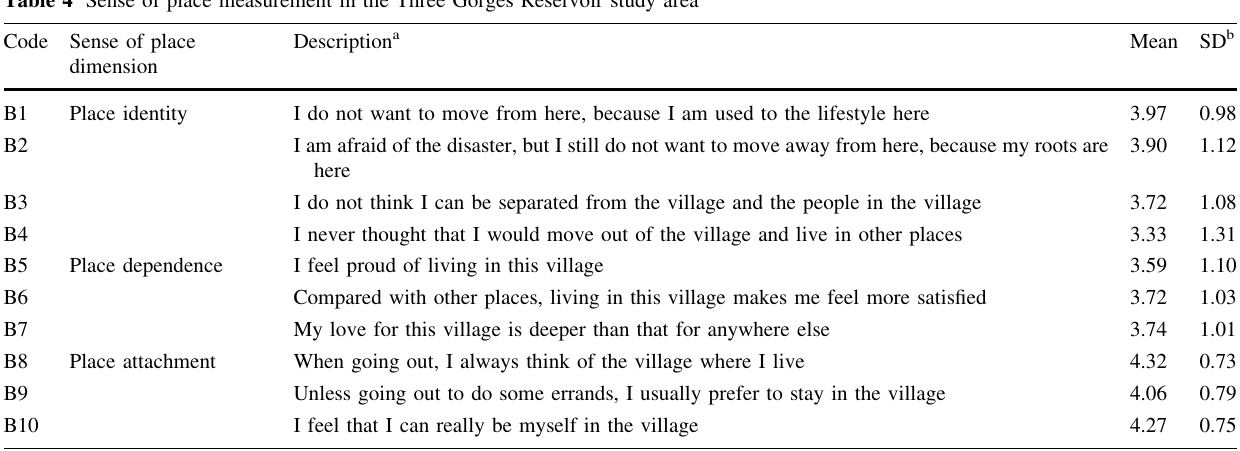
Table 4 Sense of place measurement in the Three Gorges Reservoir study area Code Sense of place Description dimension